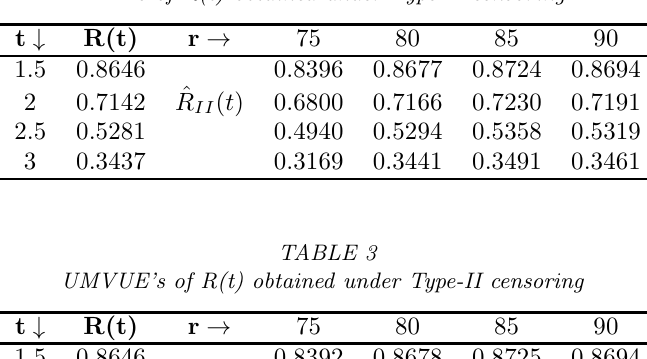
MLE’s of R(t) obtained under Type-II censoring